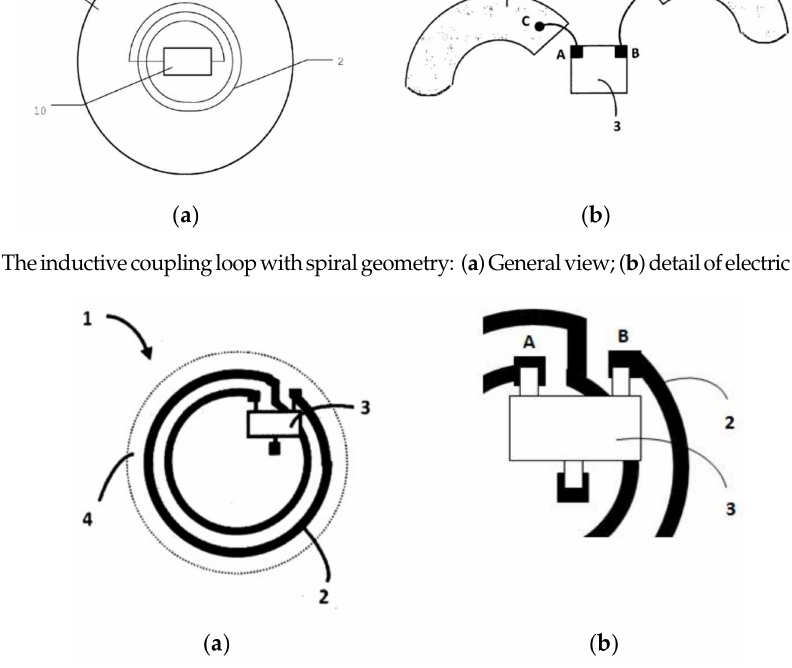
Figure 5. The inductive coupling loop of transponder with circular geometry: ( a ) General view; ( b ) detail of connections.